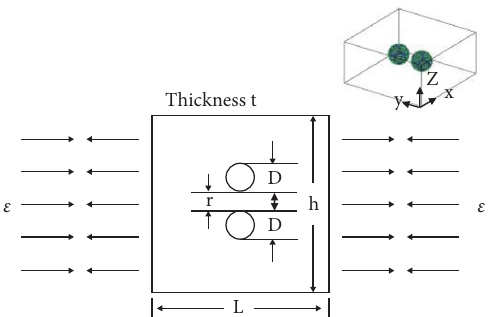
Figure 2: Loading conditions and dimensions designed for